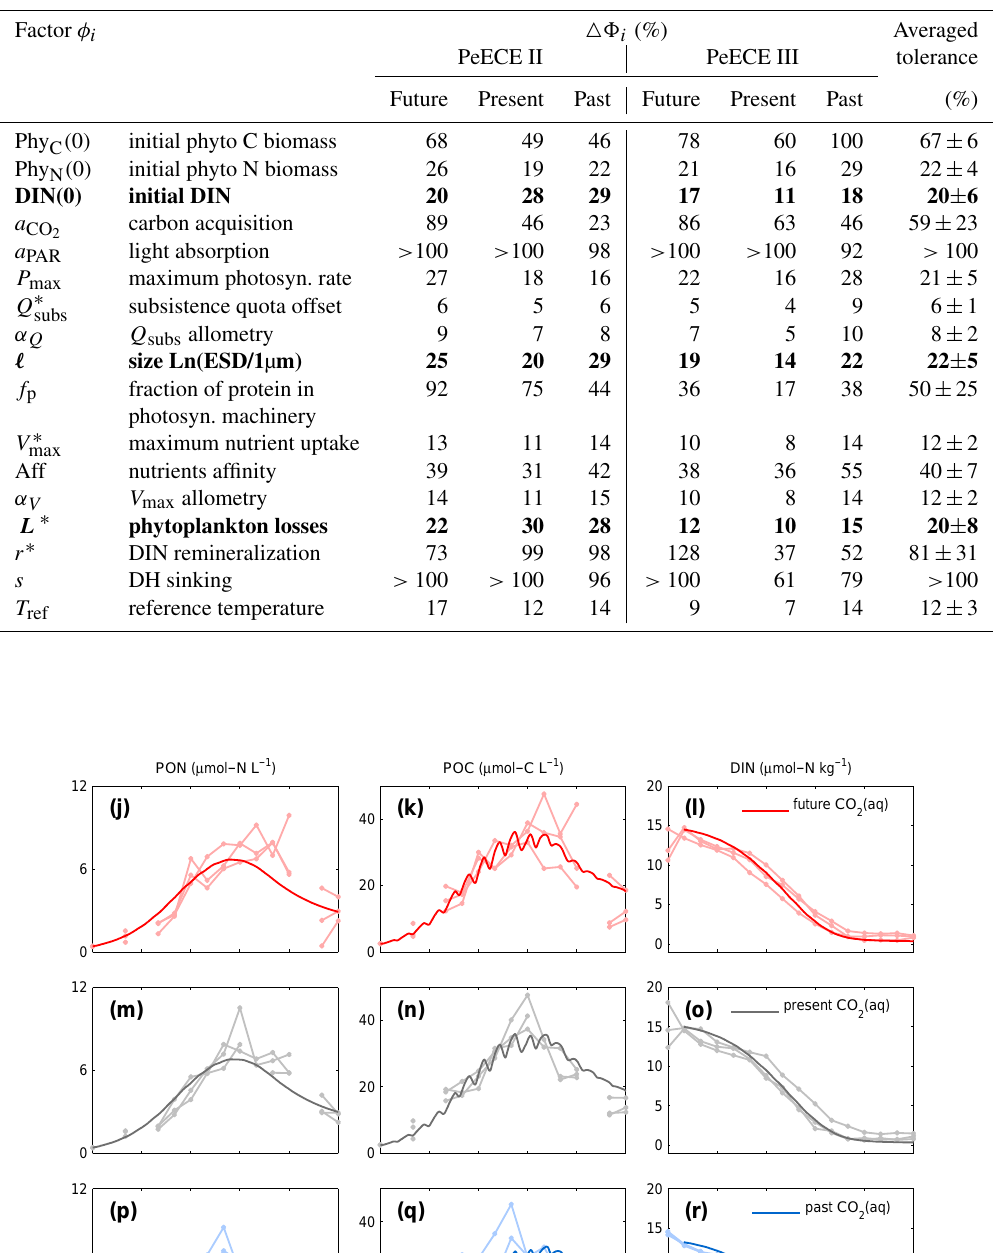
Table 3. Tolerance of mesocosms experiments to differences among replicates, given as a percentage of the reference factor value listed in Tables 1 and 2. According to our model projections, above these thresholds the simulated variability, (cid:52) POC mod variability, (cid:52) POC exp . Main contributors to the simulated variability during the bloom are highlighted in bold (see Sect. 3).